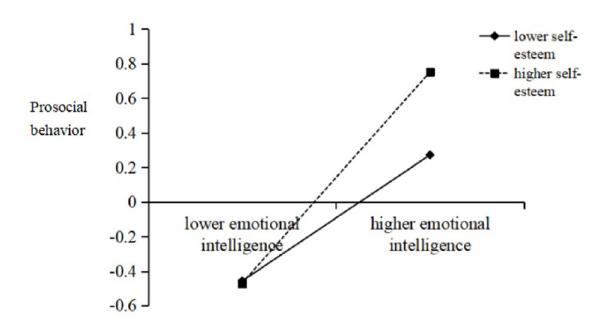
FIGURE 3 | Interaction effect of emotional intelligence and self-esteem on prosocial behavior. High and low levels of emotional intelligence and self-esteem represent one standard deviation above and below the mean, respectively.